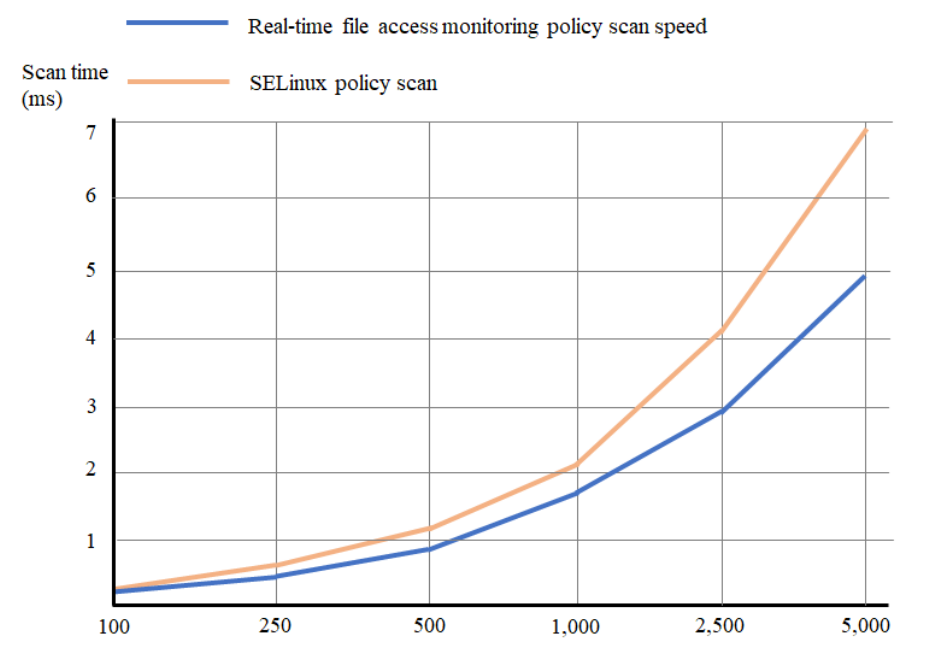
Figure 10. File access event detection time measurement.